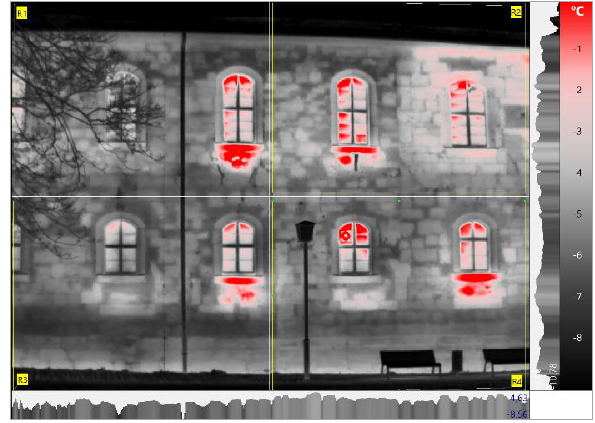
Figure 3: Merging of thermal and visual image. Location of the extent and position of the radiometric